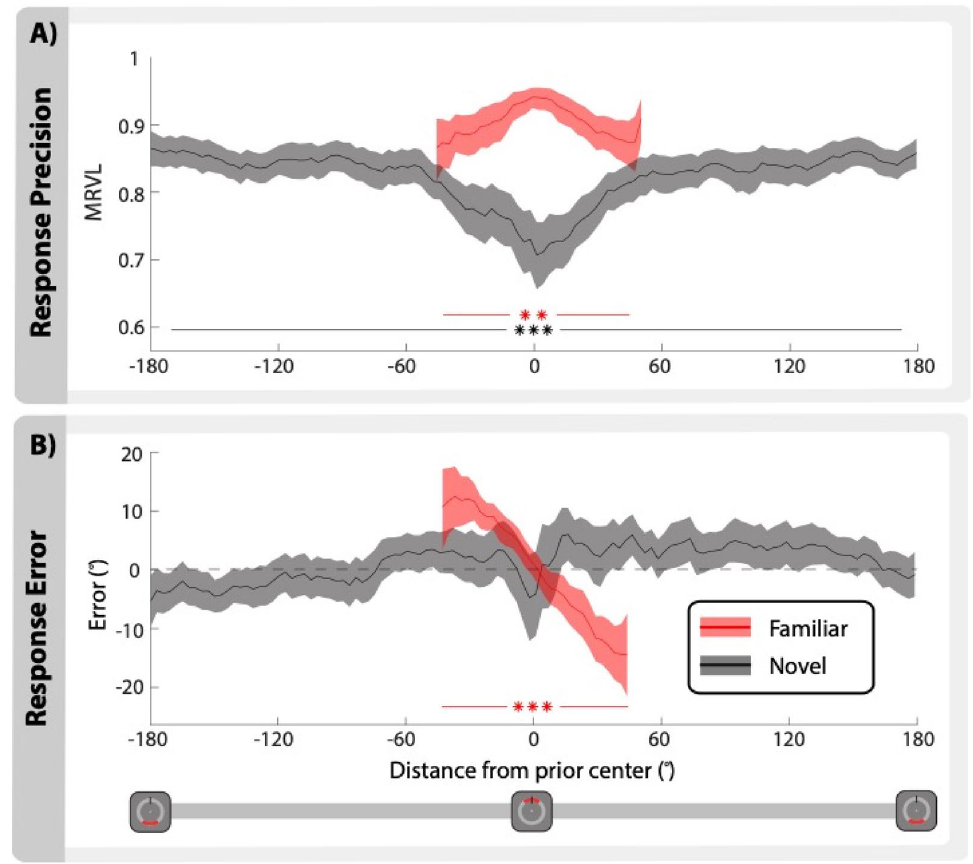
Figure 5. Attentional bias away from the prior location. ( A ) Precision and ( B ) error for novel and familiar items as a function of location, where zero marks the center of the prior location. Error is equal to the response minus the true location, where a negative slope indicates a bias towards the prior and a positive slope indicates a bias away from the prior. Familiar items did not appear outside the prior location distribution. Solid lines show the means, and the shaded areas indicate bootstrapped 95% CIs (ANOVA ** p < 0.01, *** p <